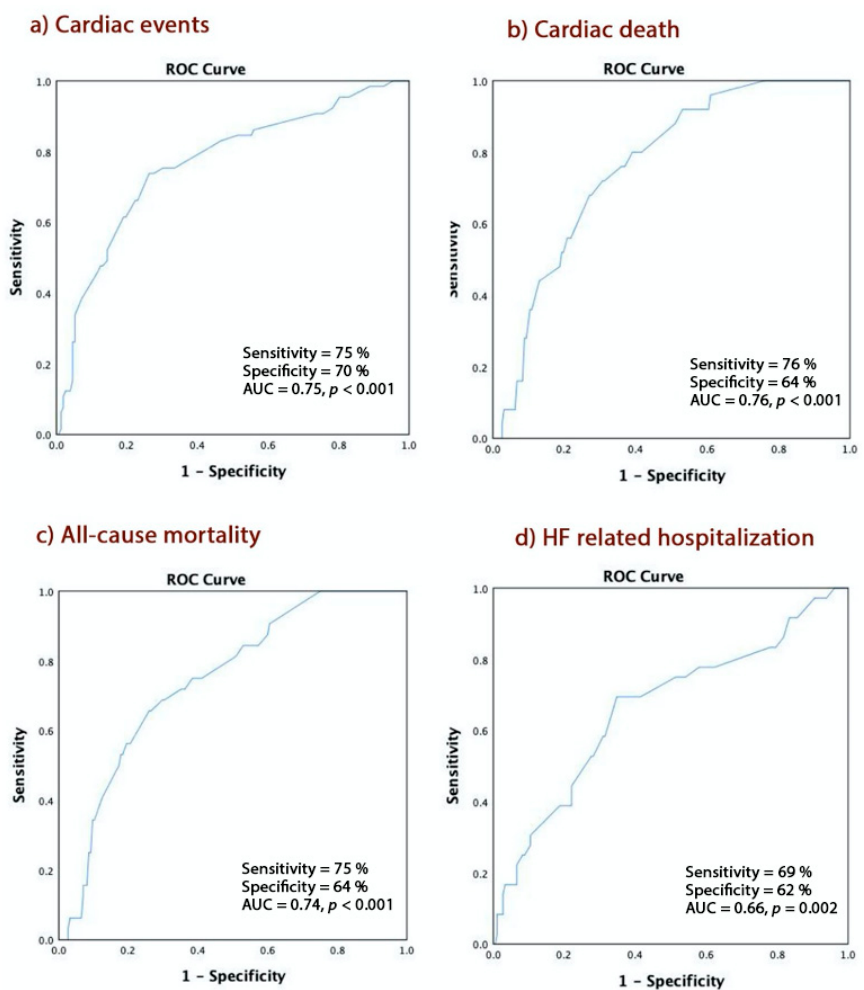
Figure A2. PAP ≥ 36 in predicting. ( a ) Cardiac events; ( b ) Cardiac death; ( c ) All-cause mortality; ( d ) HF related hospitalization. PAP: pulmonary arterial pressure; HF: heart failure.